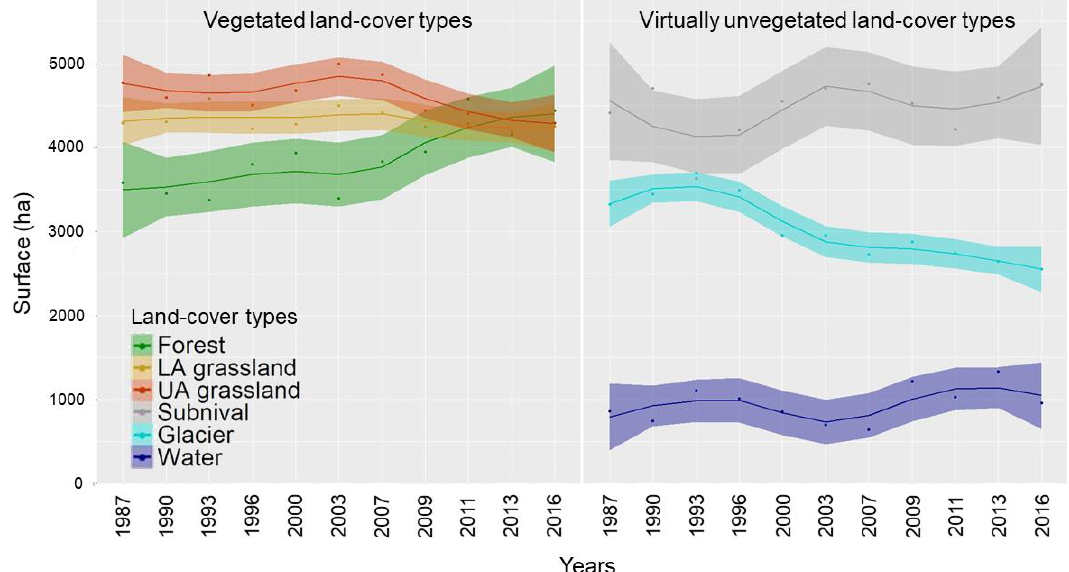
Figure 4. Trends in the occupied surfaces (ha) by the six land-cover types over thirty years (1987–2016) obtained using local polynomial regression. Vegetated and virtually unvegetated areas are shown in the two panels separately. Surfaces were obtained summing membership values of fuzzy clusters for each time window. The shaded colored areas refer to 95% confidence intervals.